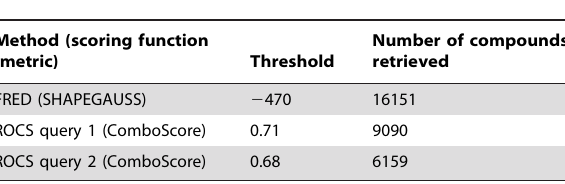
Table 2. Thresholds for FRED and ROCS adopted for initial enrichment of compound library and number of compounds resulting from each VS